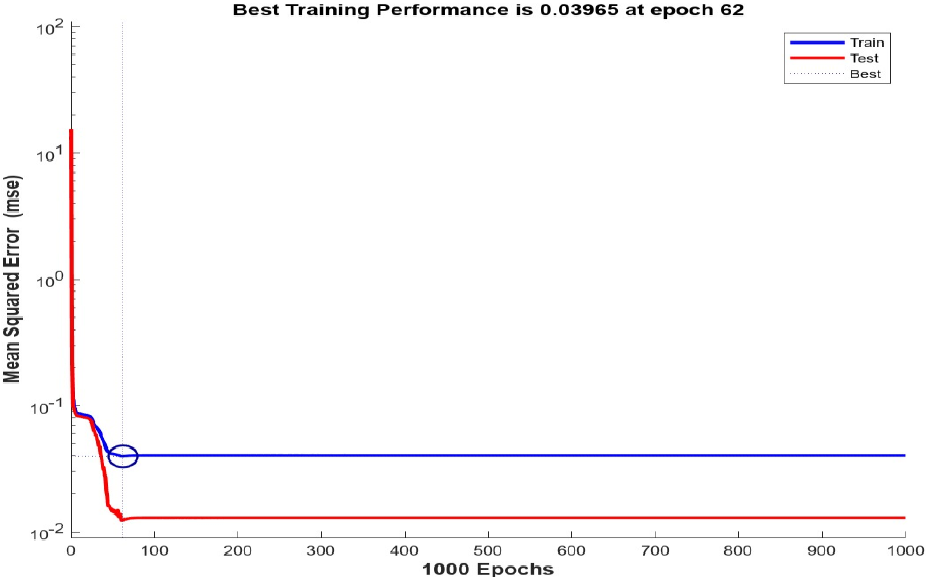
Figure 11. The BNN learning curve is as follows: the blue line is training, and the red line is the test, based on the mean squared error.